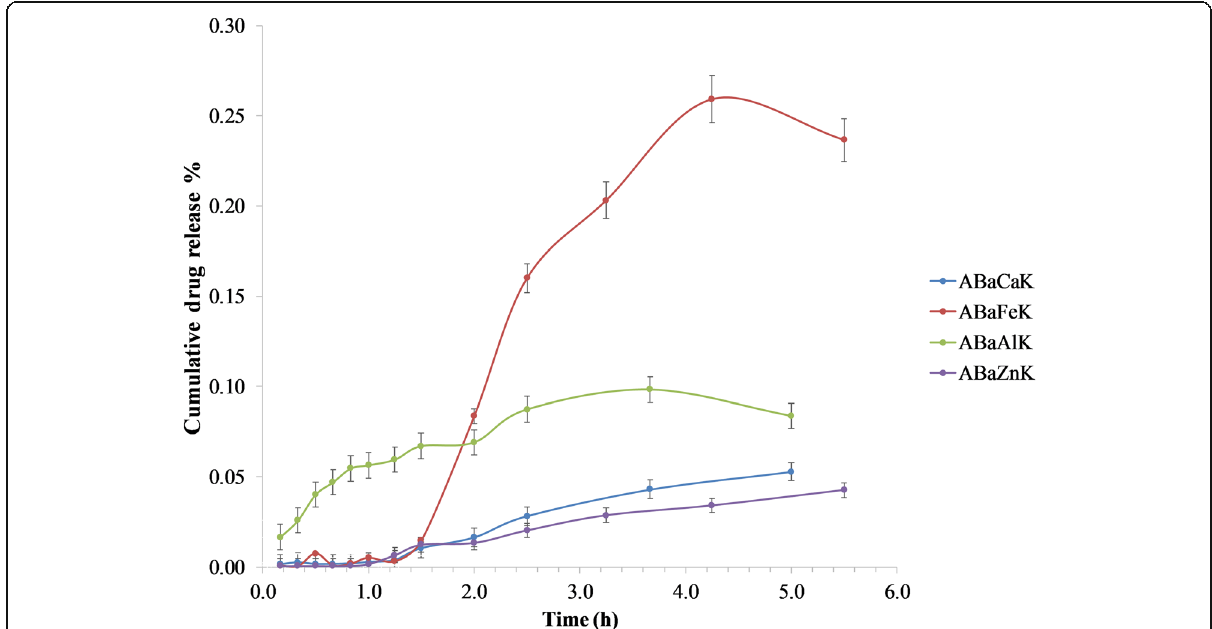
Fig. 4 Cumulative released KTP percentage curves for consecutive congealed beads (ABaCaK, ABaFeK, ABaAlK, ABaZnK), 5.5-h